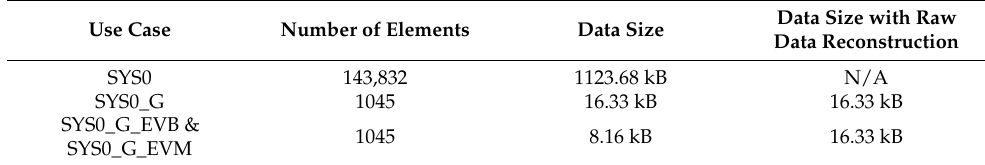
Table 10. Data size comparison with and without running the event-based algorithm.